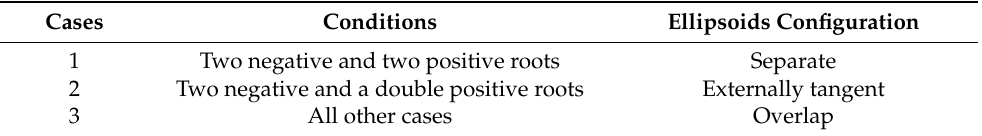
Table 1. Conditions for the configuration relationship of two ellipsoids.